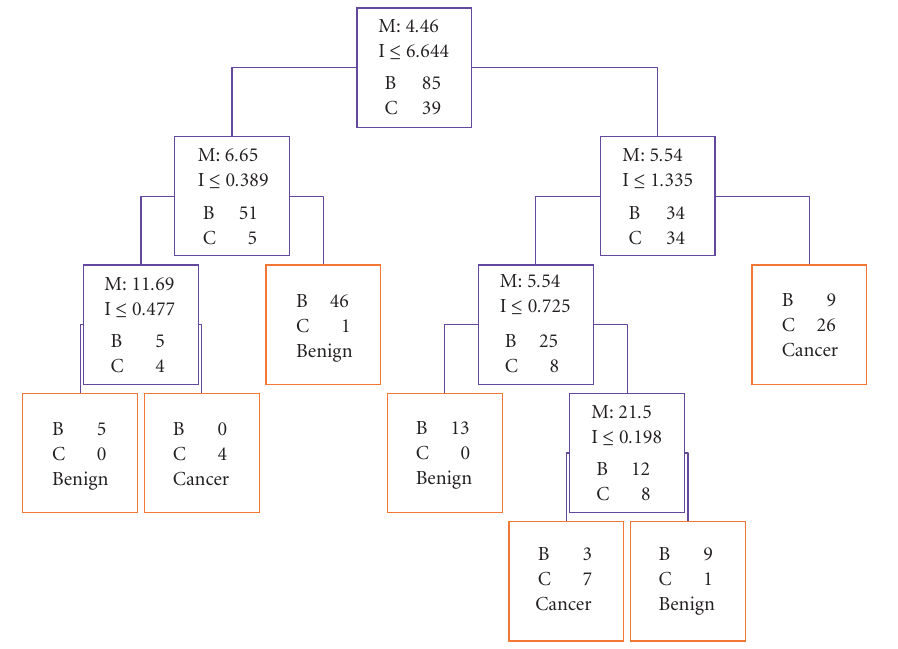
Figure 2. Decision tree classification of the ovarian cancer (C) and noncancer (normal and benign or B) groups. The blue boxes show the decision nodes with the peak mass (M in kd), the peak intensity (I) cuto ff levels, and the number of samples. The 5.54, 6.65, and 11.7 kd masses were detected on the IMAC chip, and the 4.4 and 21.5 kd on the SAX chip. These five masses form the splitting rules. Cases that follow the rule are placed in the left daughter node. The red boxes are the terminal nodes with the classification being either cancer or benign (normal +